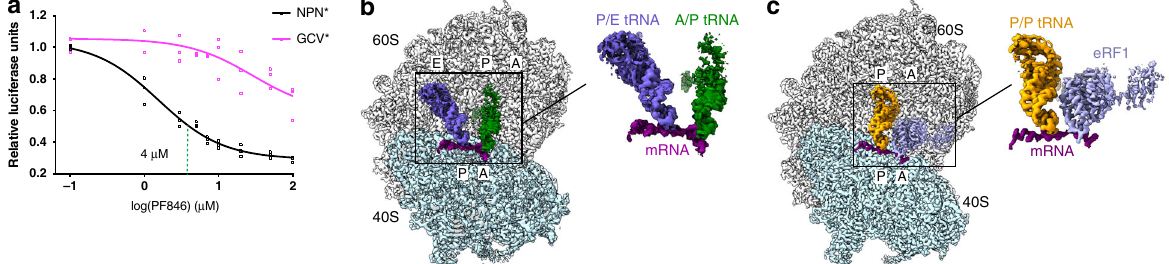
Fig. 1 Cell-based assays and structural analysis of PF846-stalled termination complexes. a Luciferase reporter assays of CDH1 – NPN* (black circles) and CDH1 – GCV* (magenta circles) stable cell lines in response to PF846 with different concentrations of 0, 1, 3, 5, 7, 10, 20, 50, and 100 μ M (data present mean ± s.d., n = 3 independent experiments). The vertical line indicates the PF846 concentration when the fi tted line crosses 0.5. From the CDH1 – GCV* data, the IC 50 of nonspeci fi c inhibition is at least 100 μ M PF846. b Structure of CDH1 – NPN* RNC in the rotated state bearing A/P-site (dark green) and P/ E-site tRNAs (slate blue), with mRNA (magenta), the 40S subunit (light cyan) and 60S subunit (gray). A close-up view of the mRNA and tRNAs is shown to the right. c Cryo-EM reconstruction of CDH1 – NPN* RNC in the nonrotated state, with eRF1 (slate blue), and P/P-site tRNA (orange). A close-up view of the mRNA, tRNA, and eRF1 is shown to the